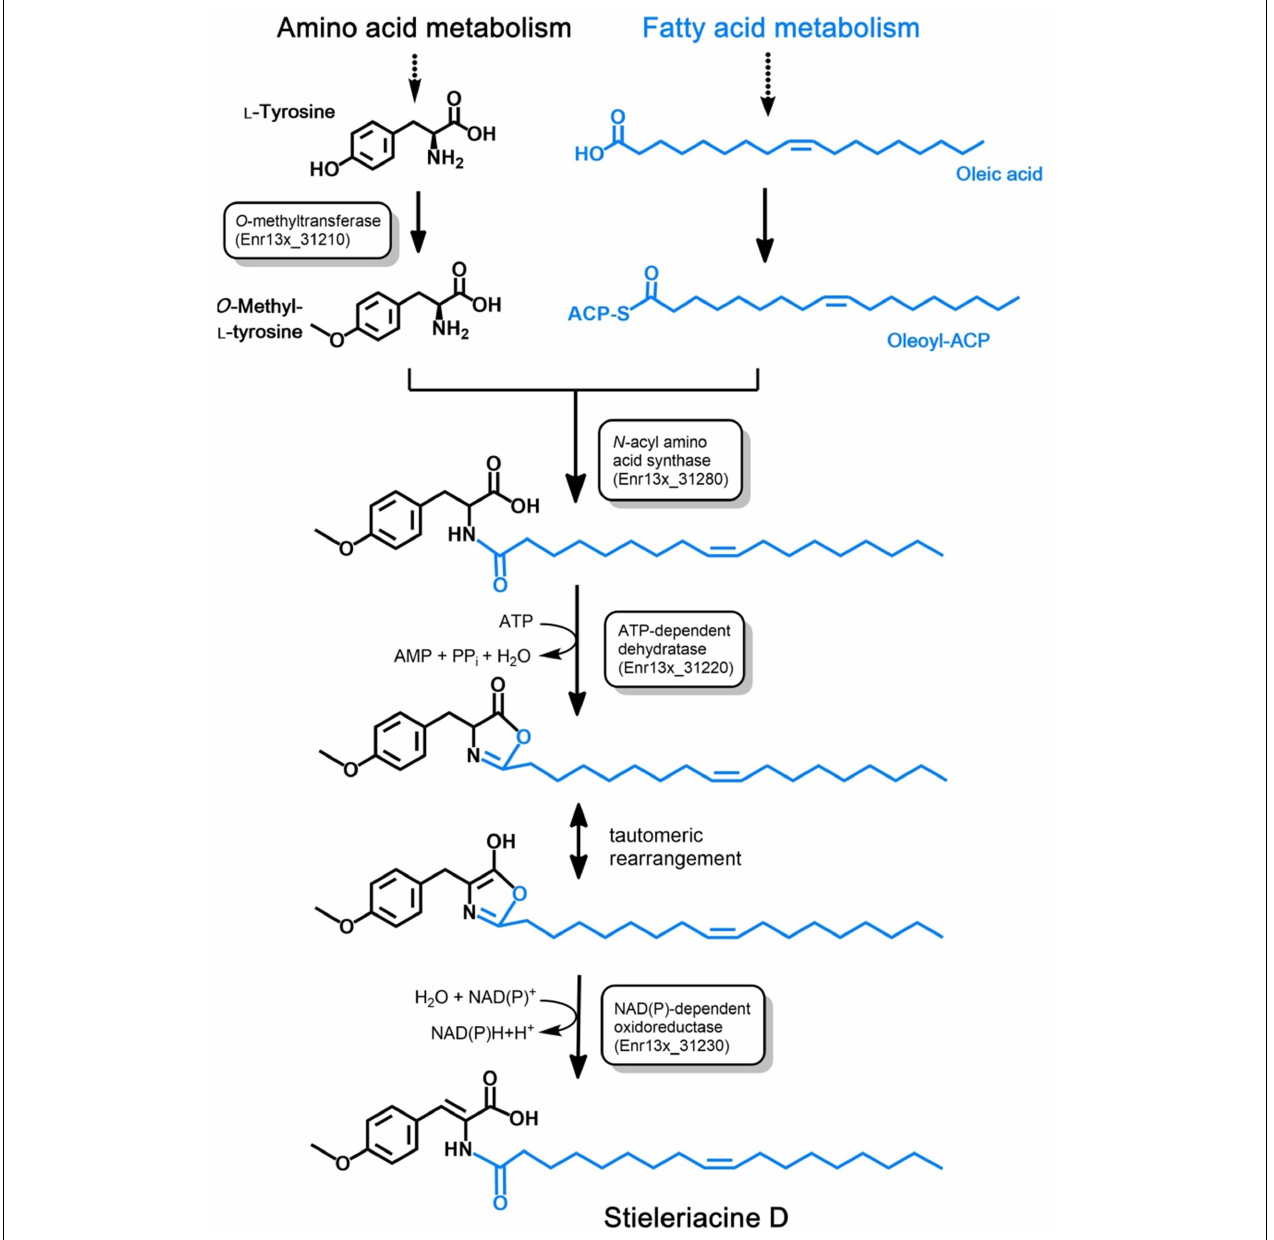
FIGURE 5 | Postulated pathway for stieleriacine D biosynthesis. The proposed stieleriacine D biosynthesis pathway starting from L-tyrosine and oleic acid in strain Enr13 T is depicted. Enzymatic activities for the required reactions steps are shown in boxes. The Enr13 T gene locus tag is given for putative enzymes with the expected activities that were found in the postulated gene cluster. ACP: acyl carrier